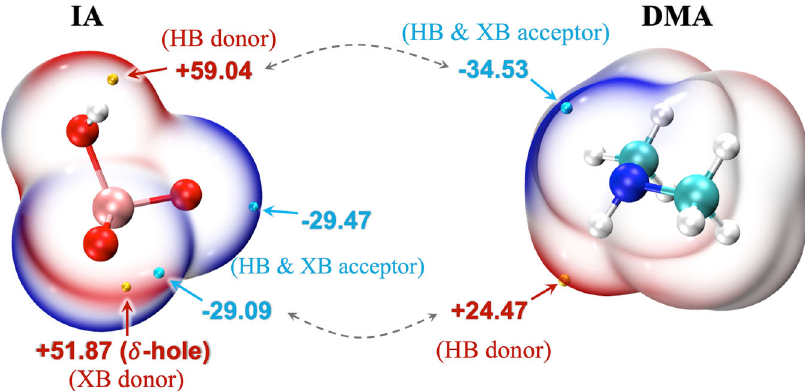
Fig. 1 The ESP-mapped molecular vdW surfaces of iodic acid (IA) and dimethylamine (DMA). The golden and cyan dots indicate the positions of maximums and minimums of ESP in kcal mol − 1 , respectively. The gray dashed arrows refer to the tendencies of site-to-site interactions. HB (Hydrogen bond), XB (Halogen bond); The pink, red, cyan, blue, and silver spheres represent I, O, C, N, and H atoms,